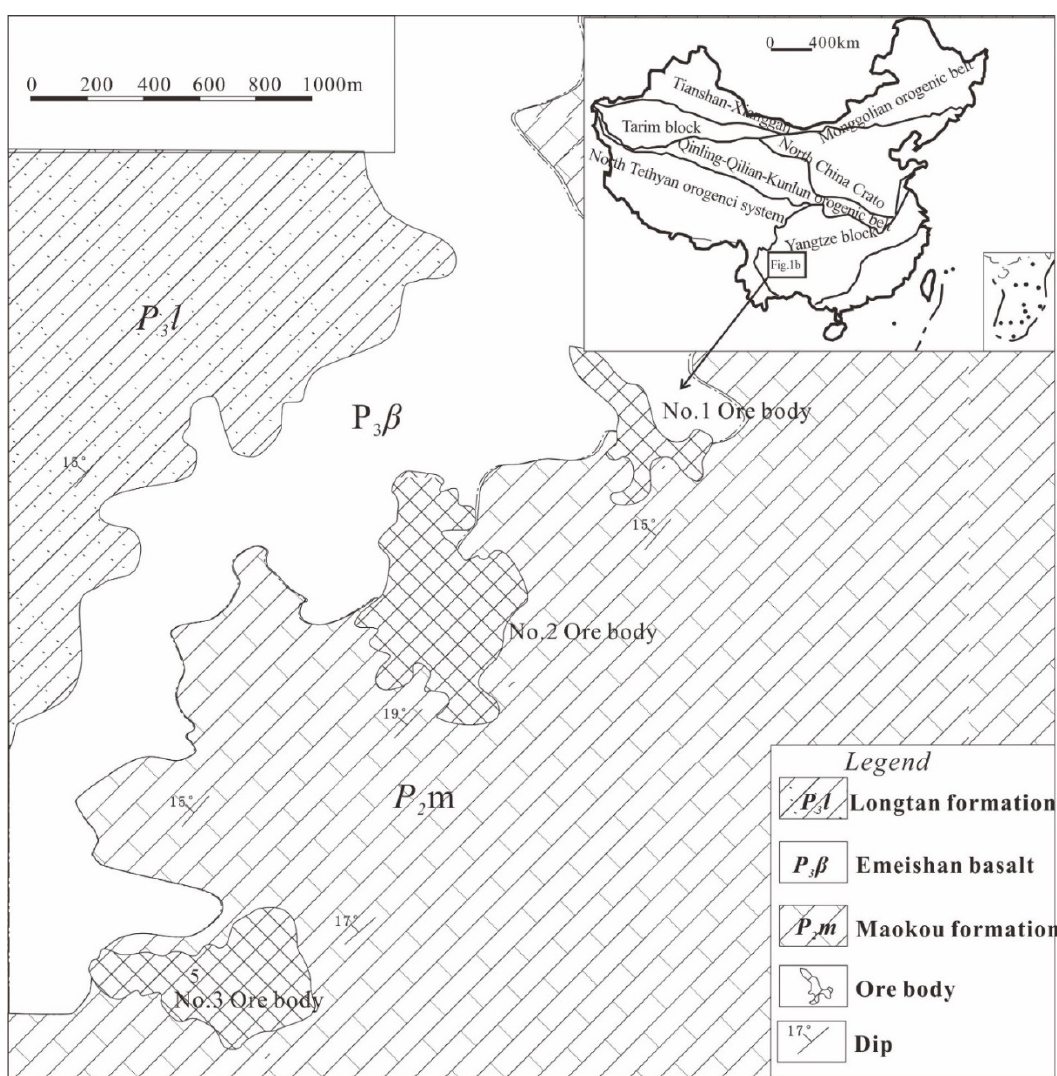
Figure 1. Geological sketch of the Shazi laterite-type Sc deposit. In the middle of the last century, the Shazi deposit was mined for TiO 2 , and the deposit was mined out at the end of the last century. In 2007, the research on the deposit found that the content of scandium in laterite was very high, reaching the cutoff grade (>0.005 wt.%); thus, it was defined as a laterite-type Sc deposit [22], but it was not mined at present. The Sc deposit occurs in the Quaternary eluvial slope red soil above the karst unconformity of Maokou limestone in the Middle Permian. Spatially, Sc ore bodies are arranged in the direction of NE–SE (Figure 1), and in the following order: No.1 ore body, No.2 ore body, and No. 3 ore body